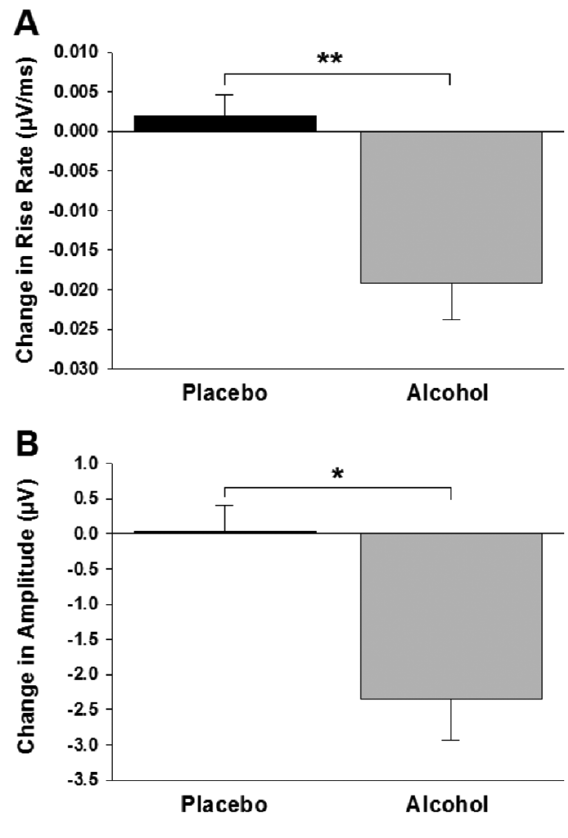
Figure 5 - Mean change in the P2 rise rate and amplitude in alcohol and placebo groups. zero represents the drug-free baseline level of performance. A negative change indicates a slower rate of rise ( A) and lower amplitude ( B) in the P2 waves. These changes are only evident in the alcohol group. Vertical bars show standard errors of the mean. * P < .001, 1-tailed; ** P < .0005,